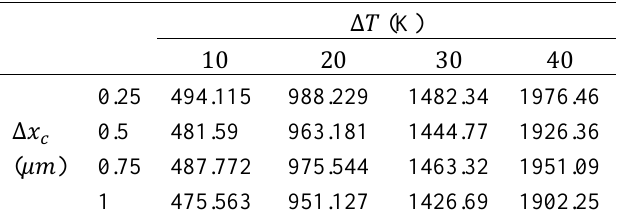
Table 3 is the mathematical iteration for heat flux